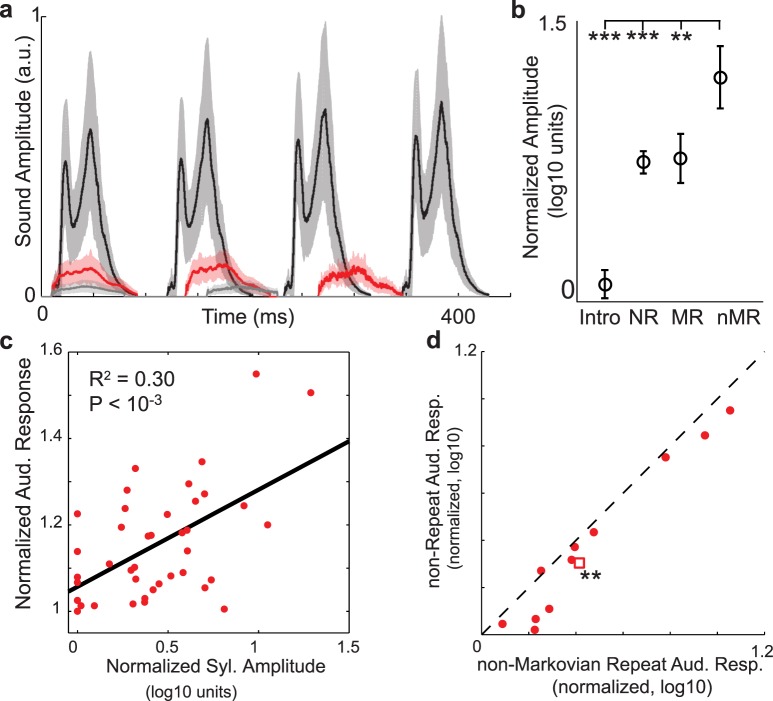
Non-Markovian repeated syllables are loudest and evoke the largest HVC auditory responses.a: Mean ±s.d. amplitude waveforms for a non-Markovian repeated syllable (black), a Markov repeated syllable (red), and an intro note (grey) from the songs of one bird. b: Mean ±s.e. normalized peak amplitudes of song vocal elements. Intro notes (Intro), non-repeated syllables (NR), Markov-repeated syllables (MR, peak repeat number = 1), and non-Markovian repeated syllables (nMR, peak repeat number > 1). non-Markovian repeated syllables are significantly louder than other vocalizations (p < 10−3, p < 0.01, Wilcoxon sign-rank test, Bonferroni corrected for m = 3 comparisons). c: Scatter plot of normalized auditory responses to a syllable as a function of the normalized amplitude of that syllable. Black line is from regression (R
2 = 0.30;p < 10−3, N = 40 syllables). d: Paired comparison of normalized auditory responses to non-repeated syllables (NR) and non-Markovian repeated syllables (nMR). Repeated syllables illicit larger auditory responses. (p < 0.01, Wilcoxon sign-rank test, N = 11 sites). Circles: data; square: median.